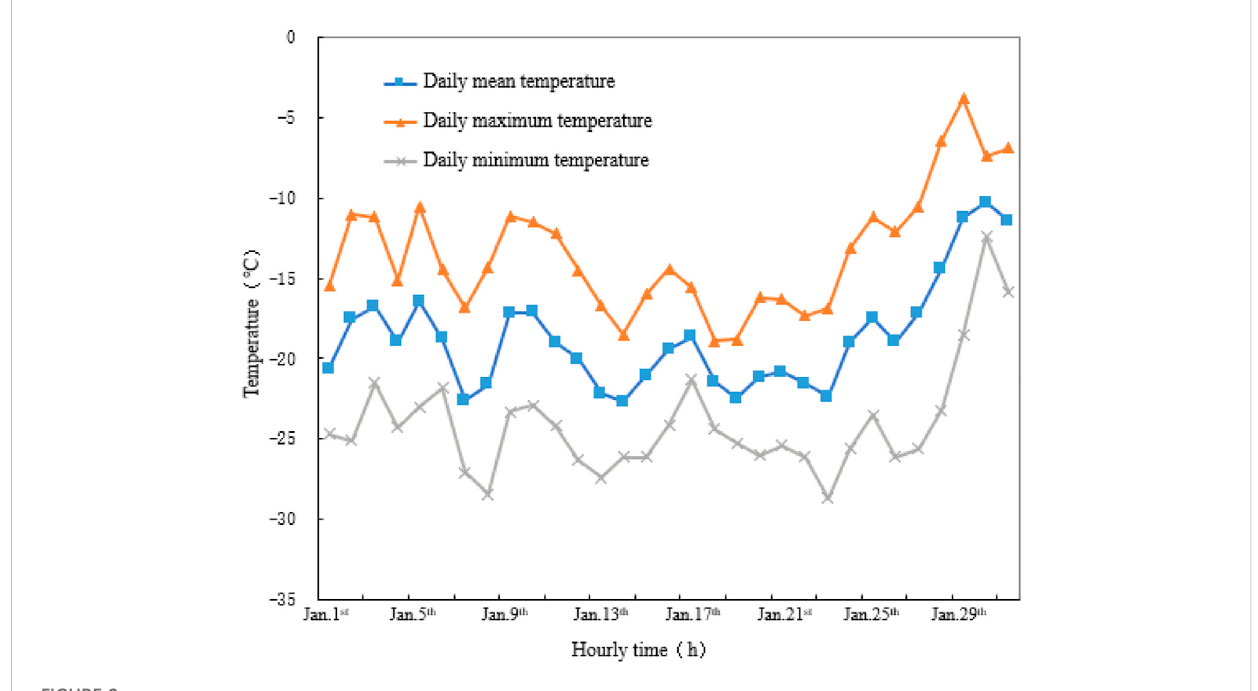
FIGURE 2 Temperature curve of the coldest month in Harbin.